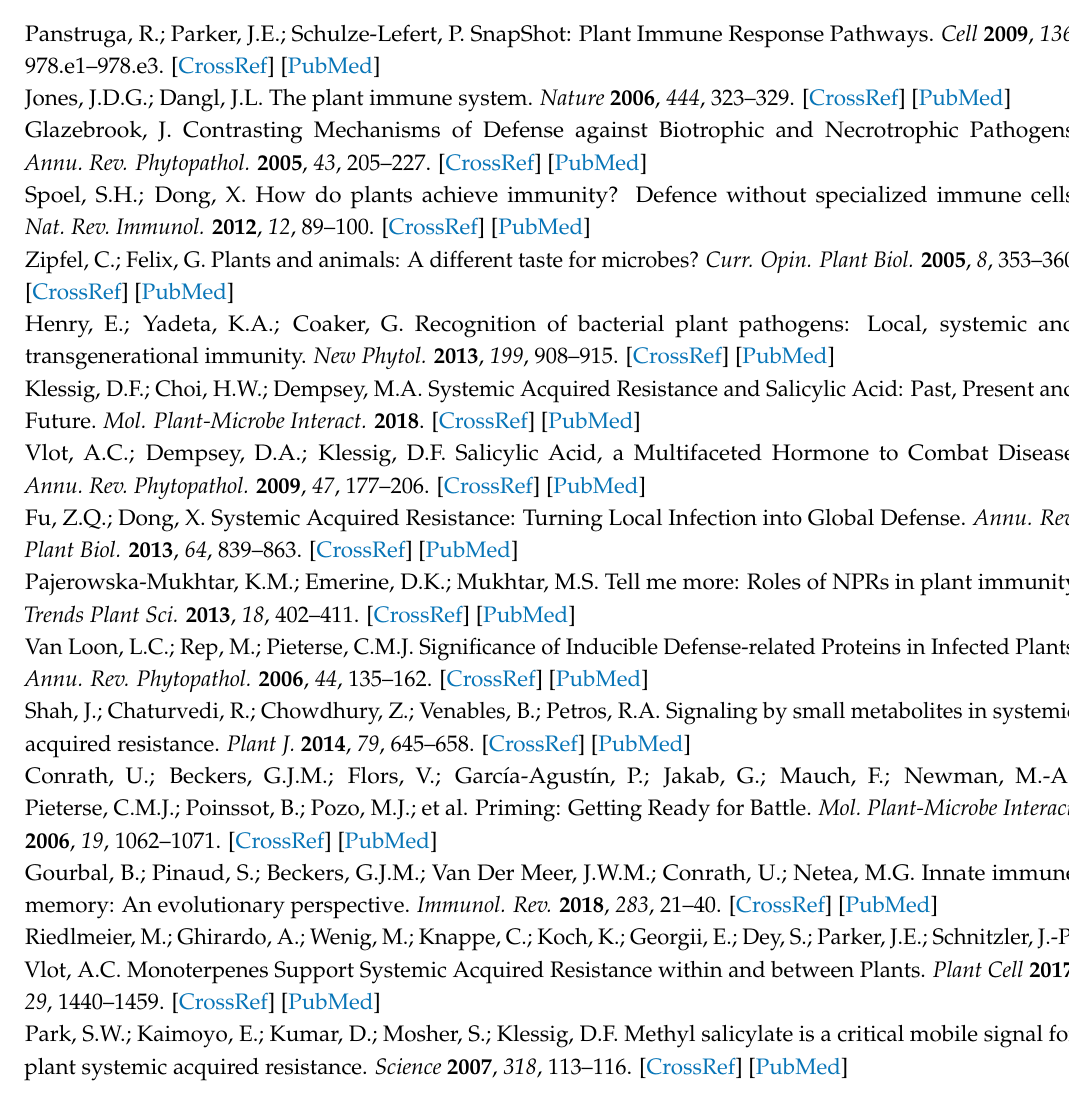
Figure S1: Fol induces resistance to Bgh , Figure S2: Size of P. teres lesions on the systemic leaves of barley after local application of SA, 50 µ M Fol, 500 µ M Fol, or